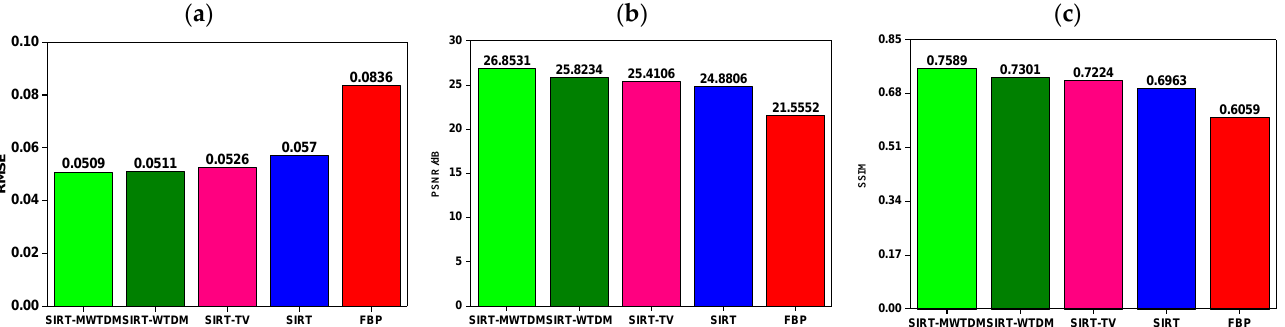
Figure 10. Reconstructed results obtained by using the different algorithms with the display windows set to [0, 1]. ( a ) Reconstructed results obtained by using FBP algorithm and 180 views; ( b ) reconstructed results obtained by using FBP algorithm and 60 views; ( c ) reconstructed results obtained by using SIRT algorithm and 60 views; ( d ) reconstructed results obtained by using SIRT-TV algorithm and 60 views; ( e ) reconstructed results obtained by using SIRT-WTDM algorithm and 60 views; ( f ) reconstructed results obtained by using SIRT-MWTDM algorithm and 60 views.